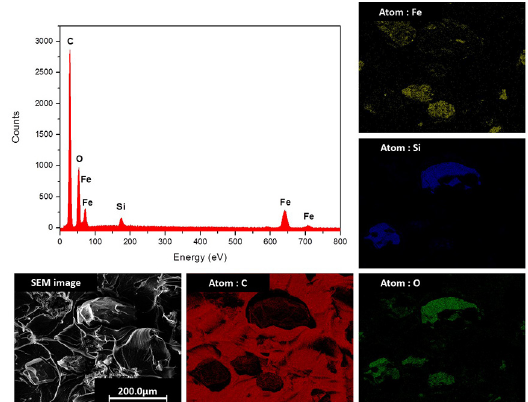
Figure 12. EDS spectra and mapping (elements C, Fe, O, Si) for the fractured surface of composite with 10% of fine iron ore, after 33 days exposure to UV